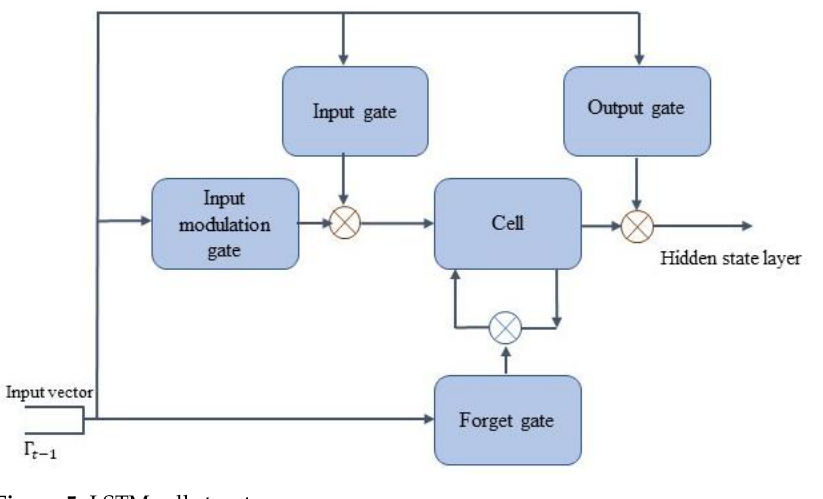
Figure 5. LSTM cell structure.